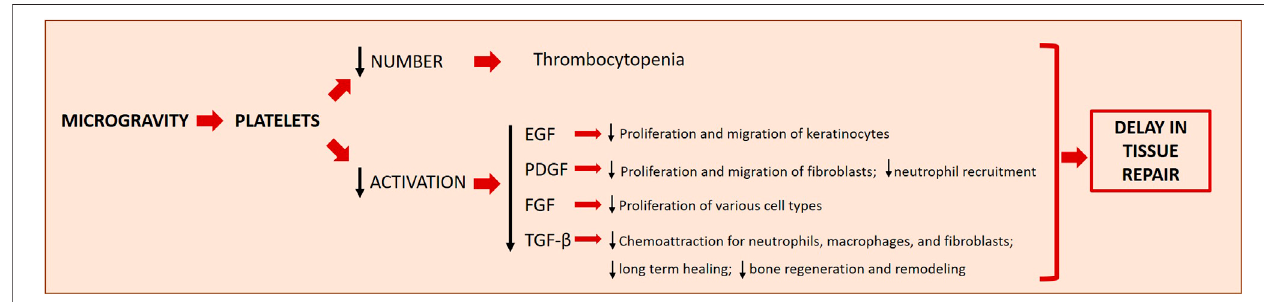
FIGURE 3 | Microgravity effects on platelets and the downstream effects on wound healing. Microgravity induces thrombocytopenia and decreases the activation of platelets, two phenomena which concur to delay tissue repair in space. The decreased production/release of different growth factors (EGF, PDGF, FGF and TGF- β ) hasdownstreameffectsonotherimportantplayersofthedifferentstepsofwoundhealing.EGF,EpidermalGrowthFactor;PDGF,Platelet-DerivedGrowthFactor;FGF, Fibroblast Growth Factor; TGF- β , Transforming Growth Factor β